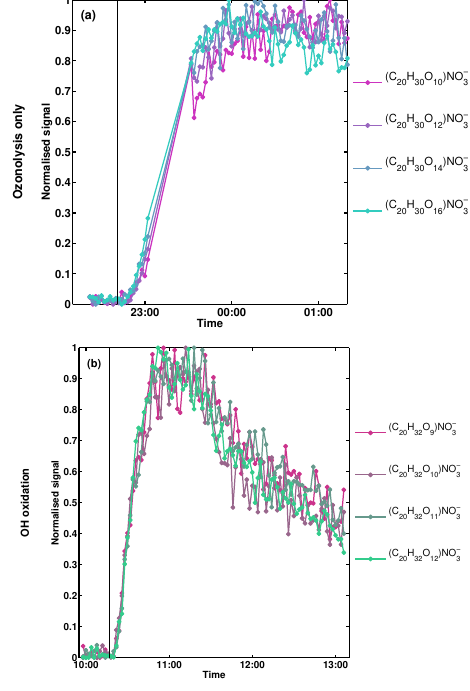
Figure 7. Time series of observed neutral clusters containing C 20 H 30 O z oxidised compounds for α -pinene pure ozonolysis (a) and containing C 20 H 32 O z for pure OH oxidation (b). The vertical black line marks the beginning of the experiment.